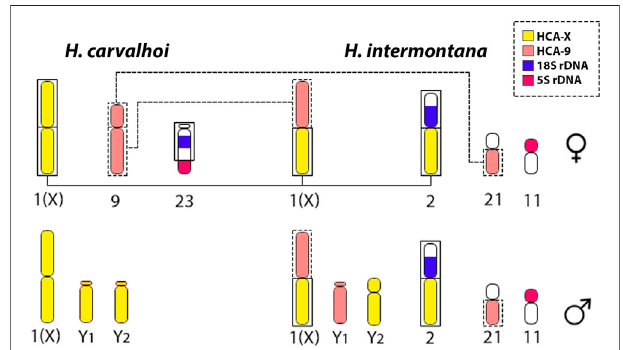
FIGURE 7 | Schematic model representing the rearrangements occurred from H. carvalhoi to H. intermontana , and the evolvement of HCA-X (yellow) and HCA-9 probes (light pink) on the origin of the XX/XY 1 Y 2 SCS. Considering H. intermontana, a derived species from H. carvalhoi , a centric fusion between the long arms of the chromosome 1 (X) and the long arms of the chromosome 9 of H. carvalhoi , lead the origin of the X chromosome in H. intermontana . An additional fusion with part of the X chromosome and part of the chromosome 23 (bearing the 18S rDNA site) gave rise to the second-largest metacentric chromosome pair in H. intermontana (pair 2). It is worth mentioning that the different origin of the X chromosome directly re fl ects on the genomic composition of the Y